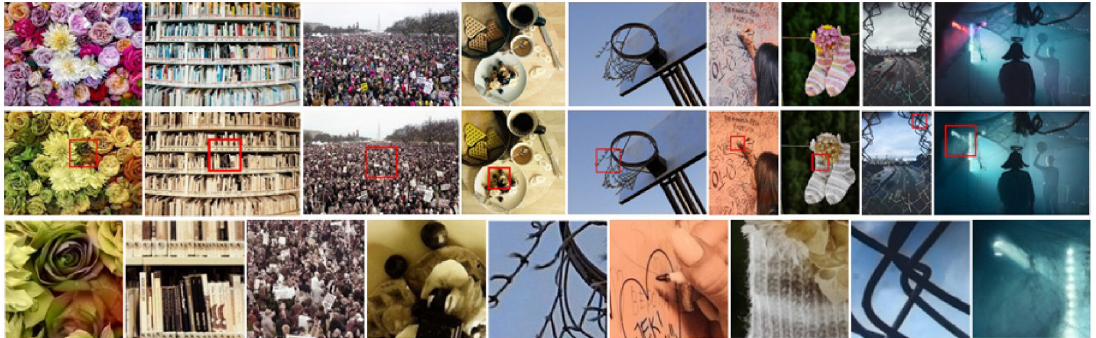
Fig 11. Limitations of our algorithm. The three rows of images from top to bottom are the ground truth, ours, and the partial zoom effect corresponding to the red box in the second row.